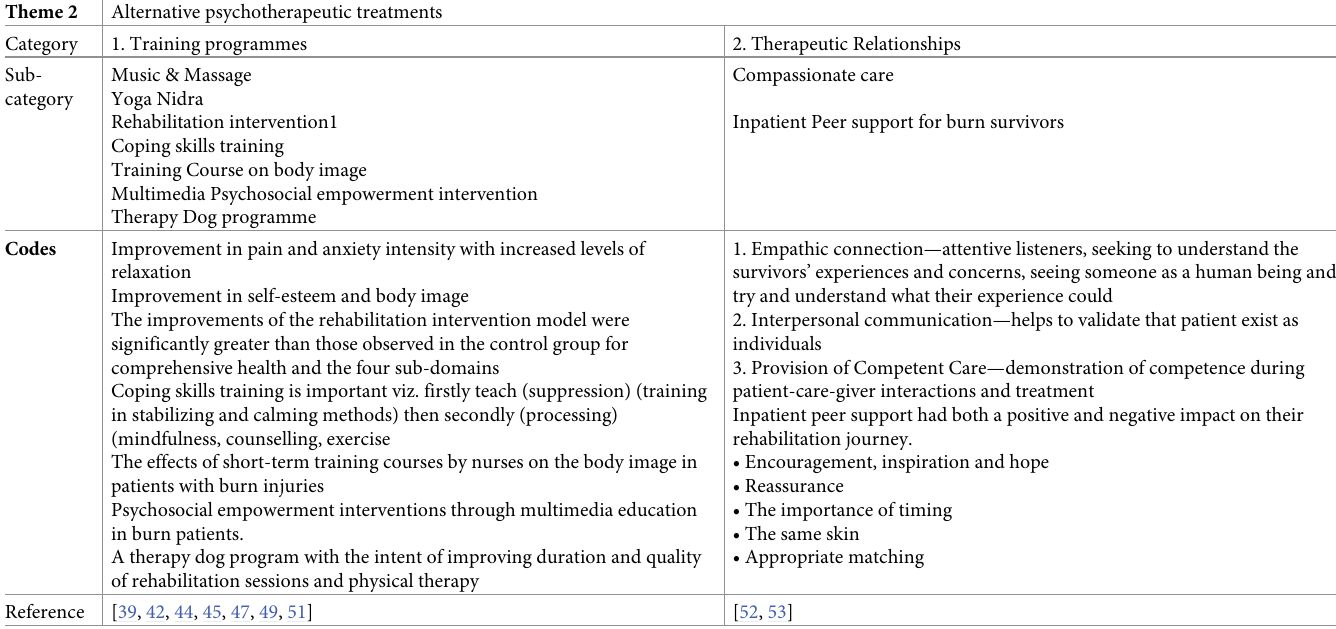
Table 5. Theme 2 alternative psychotherapeutic